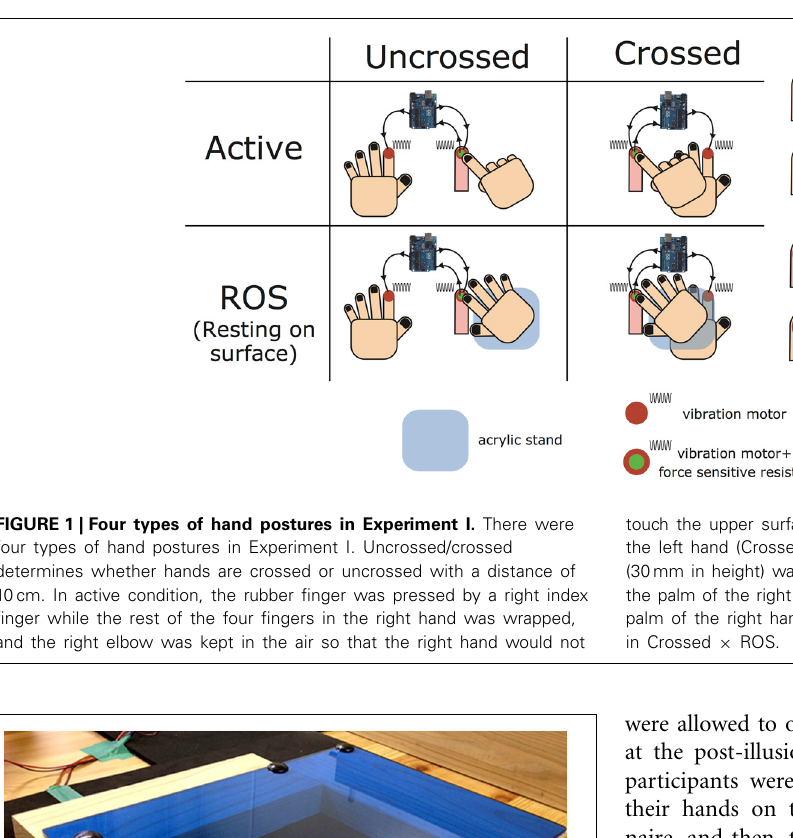
FIGURE 2 | Picture of rubber finger and acrylic stand set in the ROS condition. An acrylic stand (30mm high) was placed on the right side of the rubber finger so that the palm of the right hand could rest on the surface. In Experiment I, when the Active/ROS factor changed, the acrylic stand was located on the desk (ROS) or removed from the desk (Active). In Experiment II, the stand remained located on the desk during all